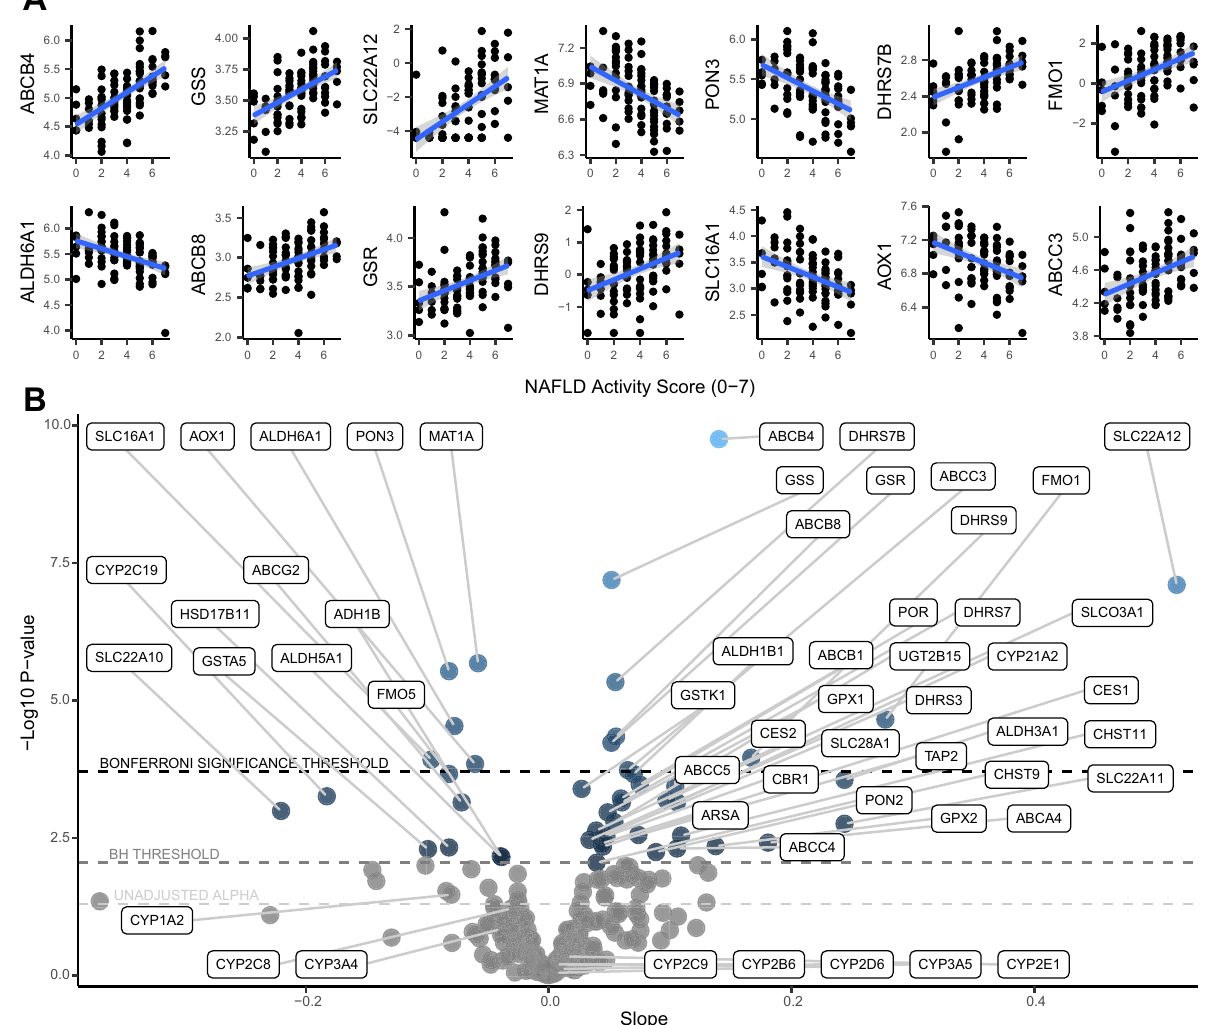
Fig.1|RegressionresultsforNAFLDactivityscore( n =93).A Regressionplotsof the Bonferroni-adjusted signi fi cant correlations between NAS and pharmacogene mRNAexpression.Lineartrendlineswere fi t(blueline)with95%con fi denceinterval region (grey). B Volcano plot showing the slopes and p-values for the regressions